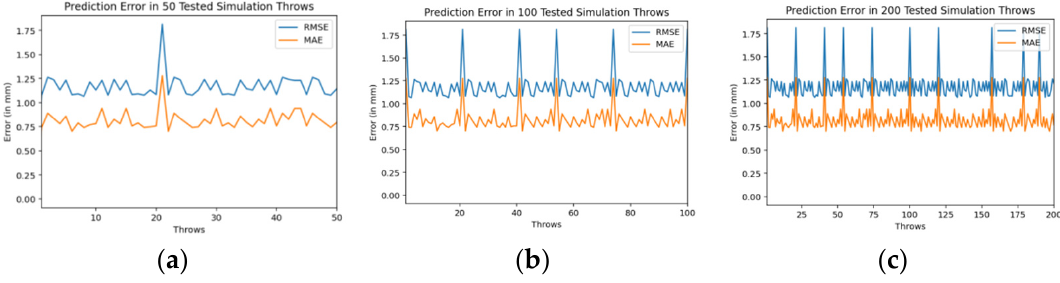
Figure 17. Prediction error results by applying proposed model for different datasets of test throws. These graphs show the accuracy of predicted values through our intelligent model. The obtained results are within the range of 2 mm error. In Figure 18, the graphs are shown, against each axis value, for 3D interception positions of a tested throw.